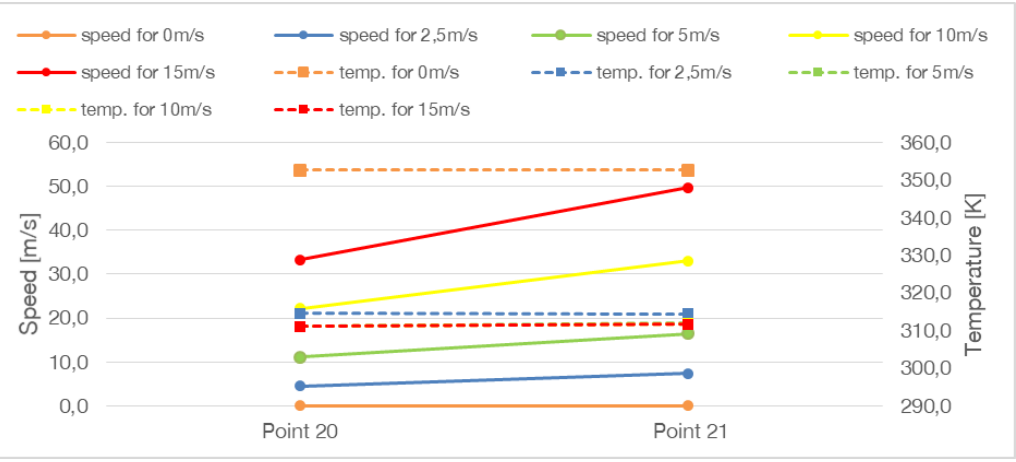
Figure 12: Compilation of temperature and air velocity for individual measurement points outside the cladding for a ventilated facade with closed joints.